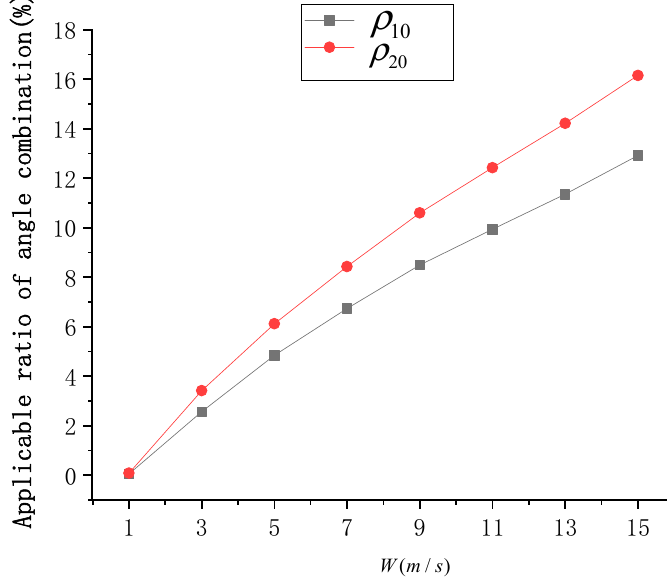
Figure 8. Statistical results of 𝜌 10 and 𝜌 20 at different wind speeds ( W ).